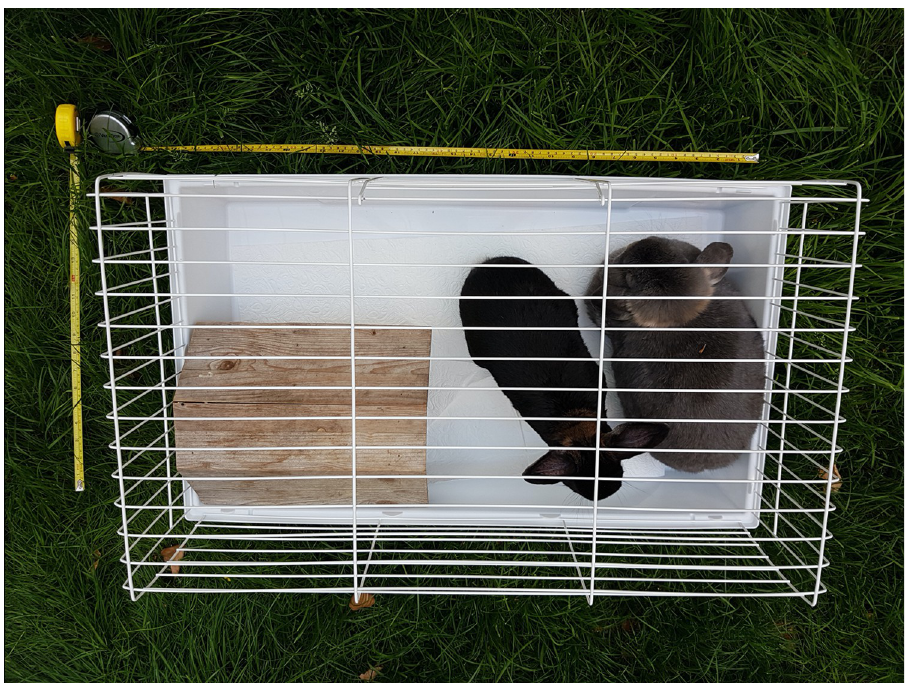
Fig 2. Pet cage available online, declared as suitable for rabbits, hares, and guinea pigs. Because every cage must offer a retreat possibility for the animals, a “hiding place” was put in the cage to demonstrate proportions. The cage dimensions provided by the manufacturer are: 80 cm × 46 cm × 36 cm (L × W × H). The black and the gray rabbit have a body weight of approx. 1.7 kg and 3.1 kg, respectively. (Photo: M. Ebner, 2018.).